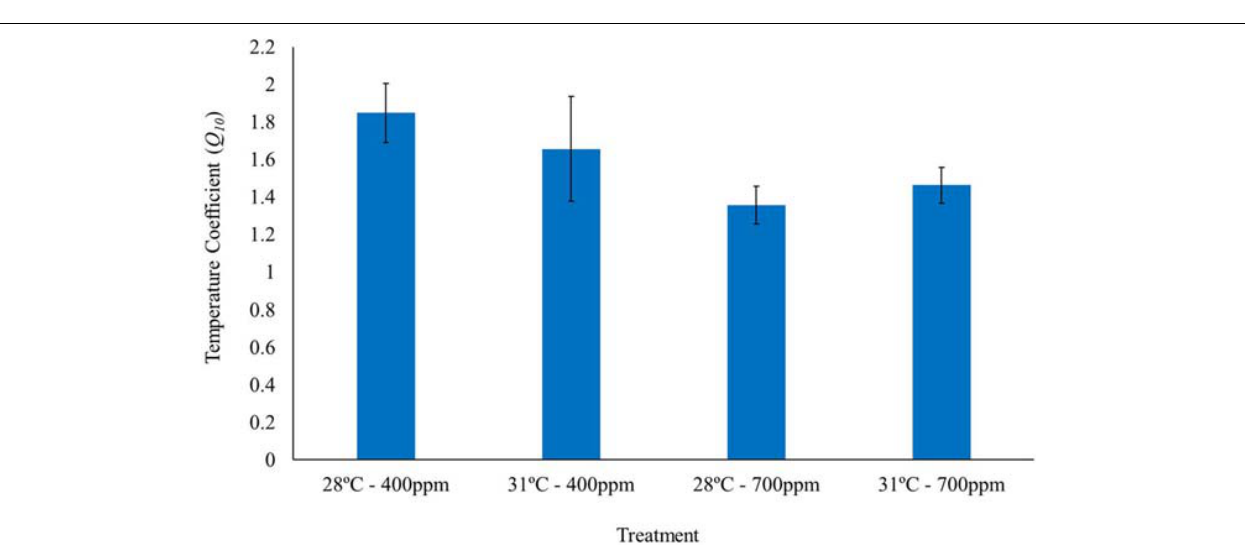
FIGURE 1 | Thermal ramps showing metabolic rates (mg L − 1 g FW − 1 h − 1 ) of the gastropod Trochus maculatus ( n = 10) after 12-weeks exposure to (A) control conditions (28 ◦ C, 400 ppm) (B) high temperature (31 ◦ C, 400 ppm) ( C ) high CO 2 (28 ◦ C, 700 ppm) and (D) a combination of both high temperature and CO 2 (31 ◦ C, 700 ppm). Curves are modeled using an Exponentially Modified Gaussian Function.